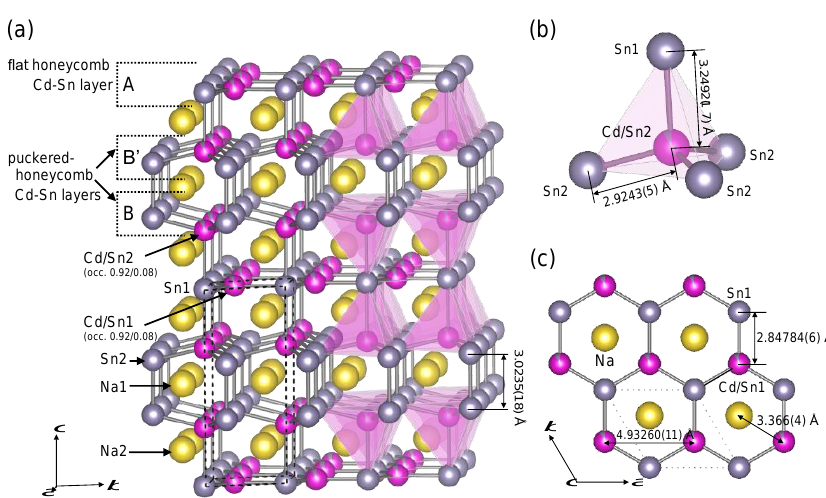
Figure 2. Crystal structure of NaCd 0.92 Sn 1.08 : a general view ( a ), a structural motif of Cd/Sn2-centered Sn tetrahedron, and ( b ) Cd – Sn honeycomb sheet ( c ).